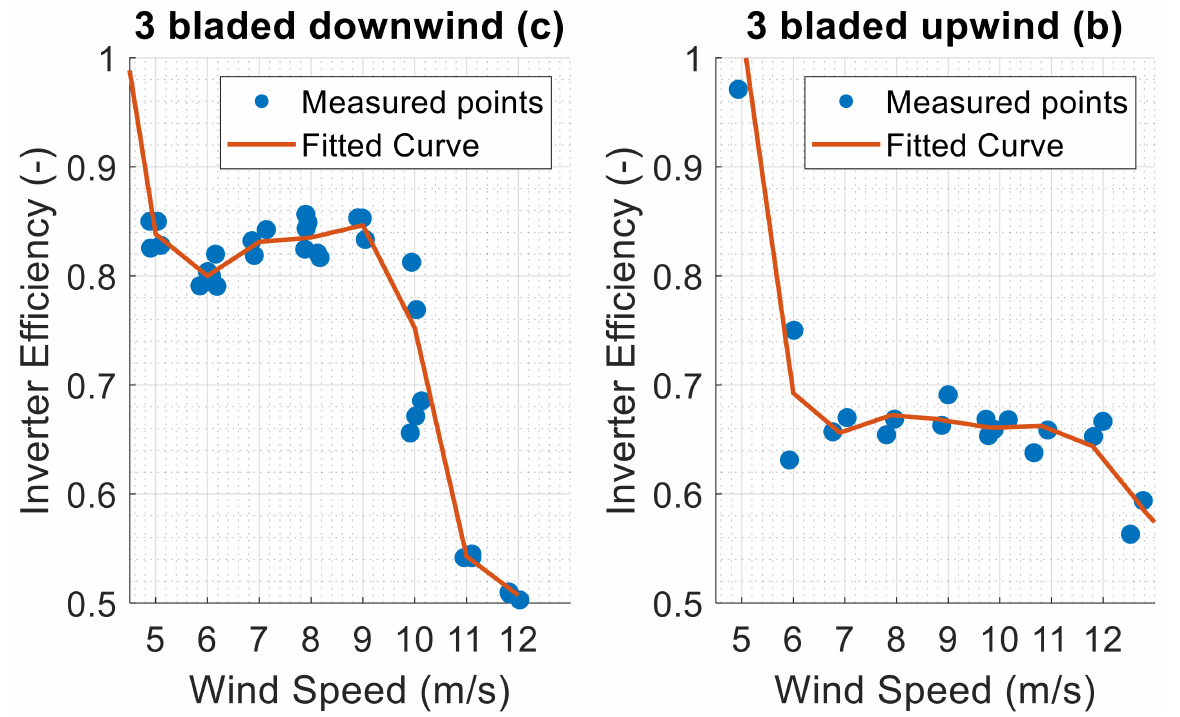
Figure 13. Wind tunnel measured inverter operating efficiencies as a function of wind speed for ( left graph) the (c) configuration of 3-bladed downwind and ( right graph) the (b) configuration of 3 bladed downwind